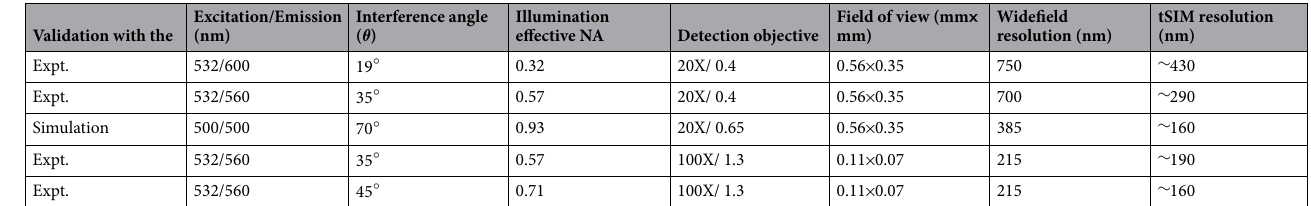
Table 2. Super-resolution achieved by tSIM under different illumination-detection